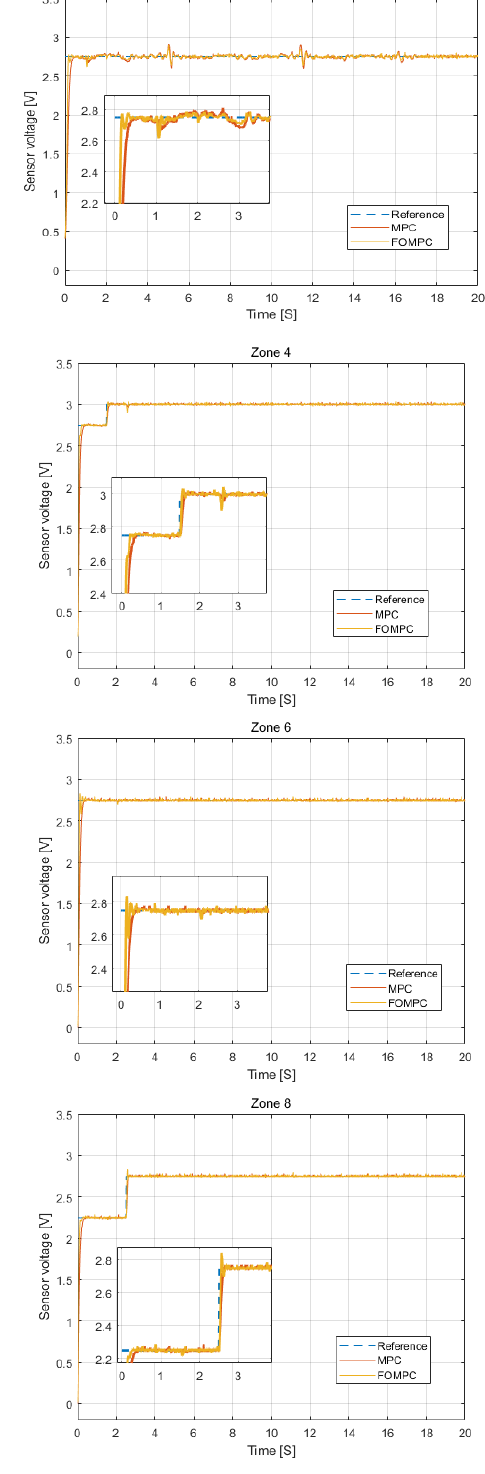
Figure 7. Output of multiple lighting control with MPC and FOMPC in reference tracking experi ‐ ment.